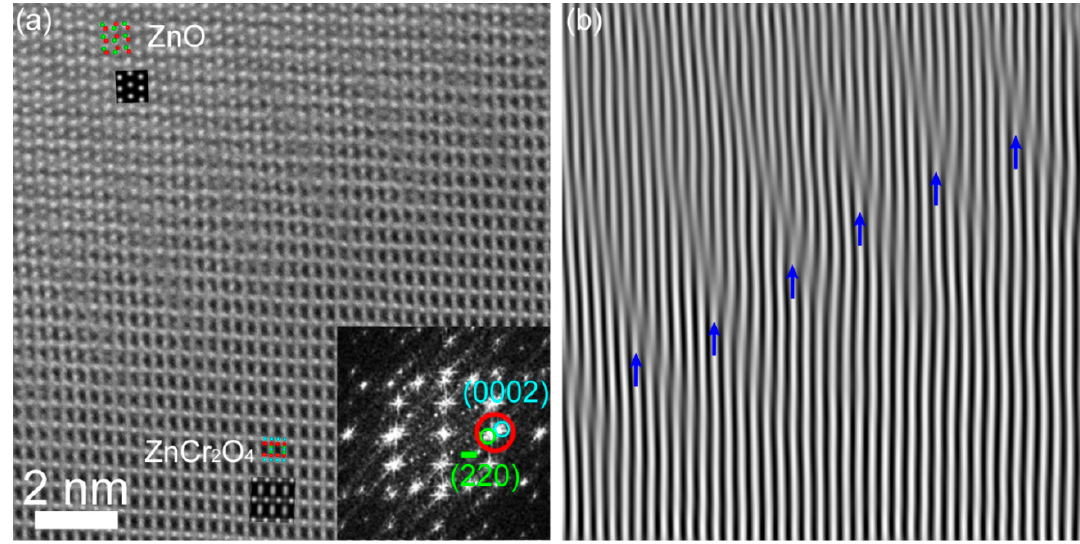
Figure 6. ( a ) HAADF image of ZnO [1210]/ZnCr 2 O 4 [112] interface. The inset at the bottom right of the HAADF image displays its FFT, and the circles show the lattice fringes. The simulated images and the corresponding projected models of ZnO and ZnCr 2 O 4 are also inserted, and their close-ups can be found in Figure S5b,c (Supplementary Materials). ( b ) Fourier-filtered image of (0002) ZnO /(220) ZnCr2O4 lattice fringes.